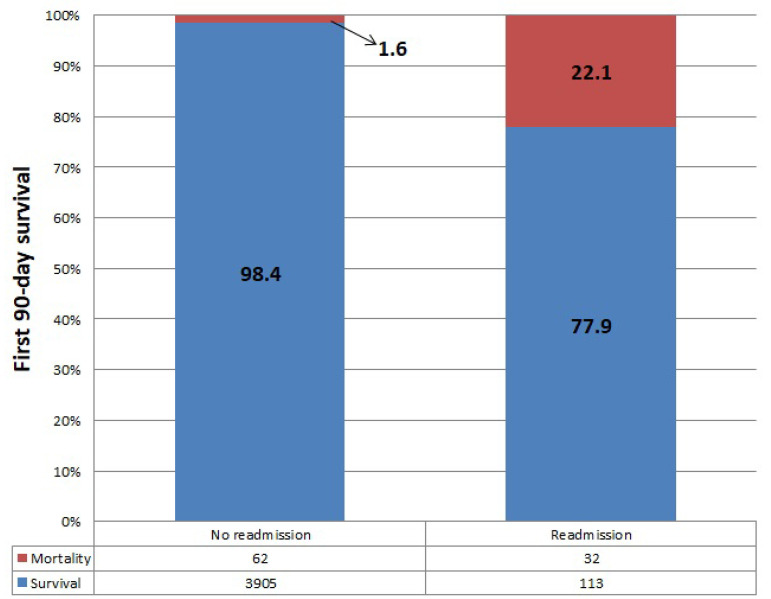
First 90-day survival of study patients.